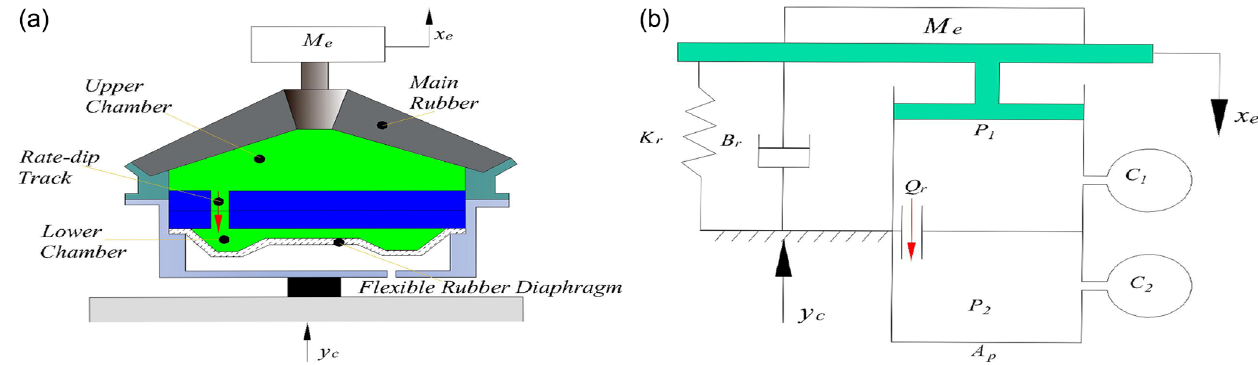
Figure 7. Equivalent hydraulic mount when all controllable channels are closed: (a) schematic diagram and (b) lumped parameter model.